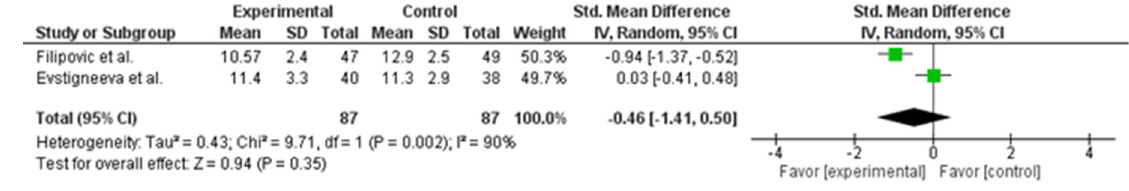
Figure 3. Forest plot (timed up and go) [22,23].